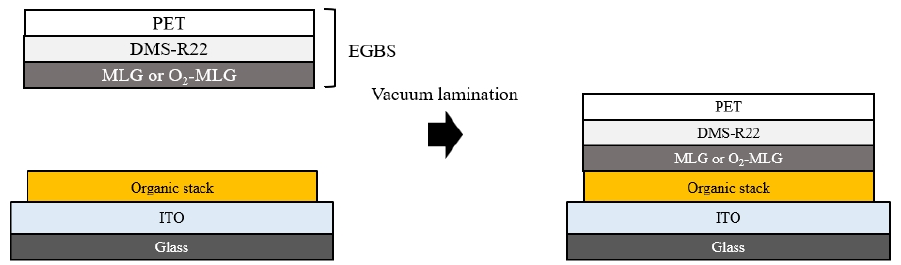
Figure 1. The fabrication of TOLEDs using vacuum lamination.